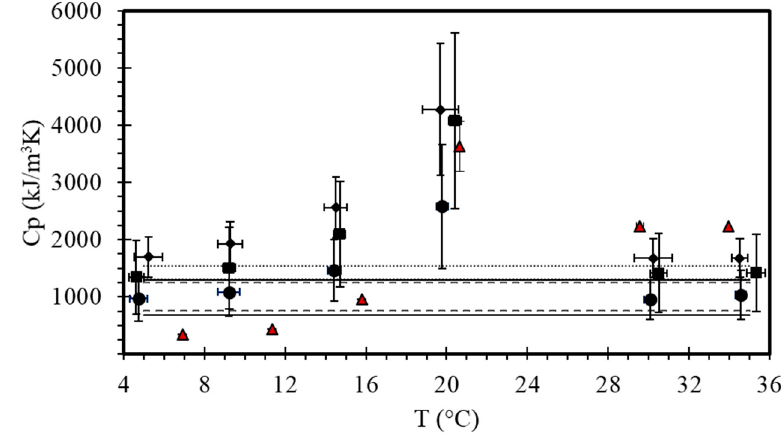
Figure 12. Volumetric specific heat of Pinus radiata wood impregnated with octadecane (longitudinal: rhombus; tangential: square and radial: circle), of the unimpregnated wood (longitudinal: solid line; tangential: dashed line and radial: dotted line) and octadecane (red triangle).